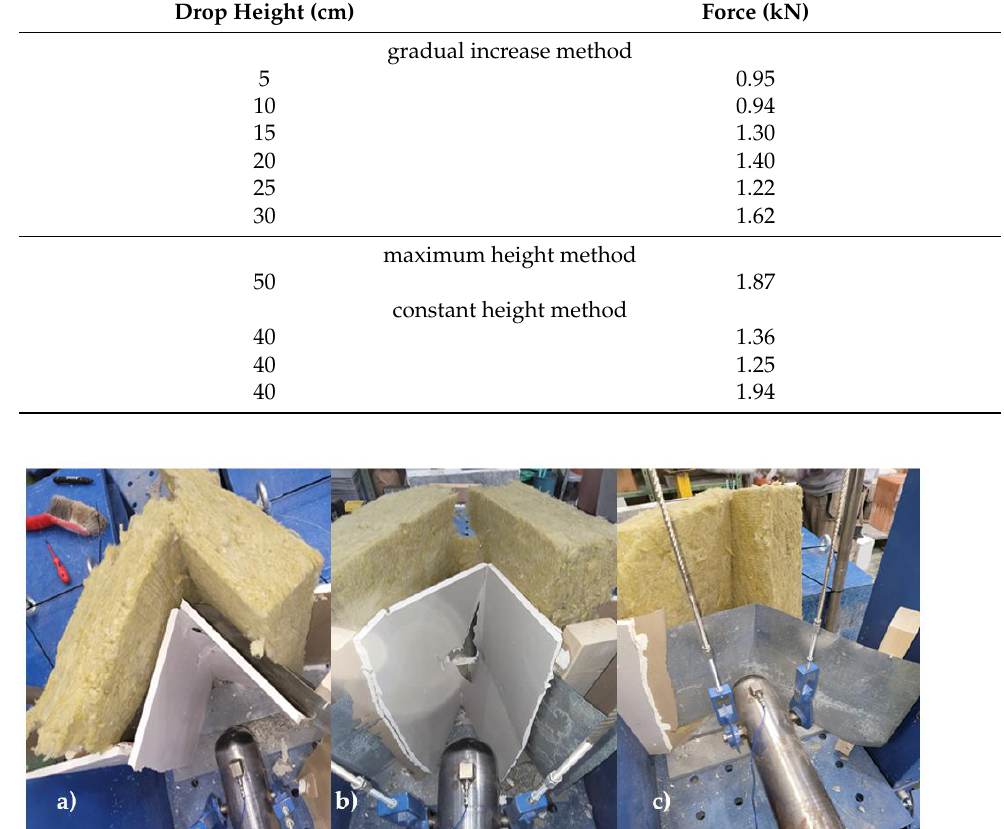
Figure 8. Plasterboard reinforced with 1 mm thick sheet metal testing results—( a ) gradual increase method, ( b ) maximum height method, ( c ) constant height method.